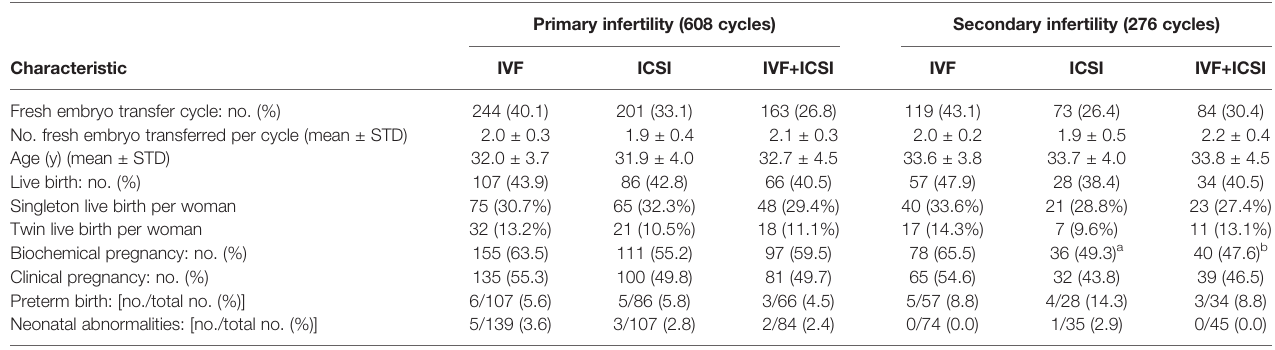
TABLE 5 | Clinical outcome of primary infertility and secondary infertility half-ICSI patients with fresh embryo-transfer cycles.